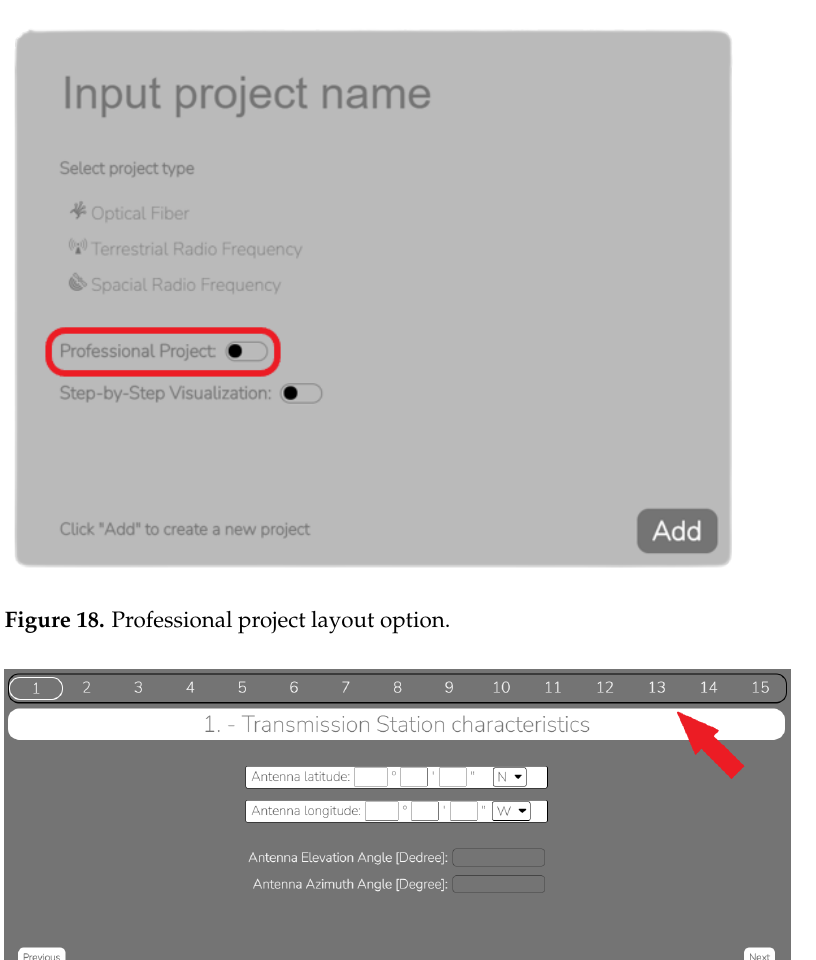
Figure 19. Project step display